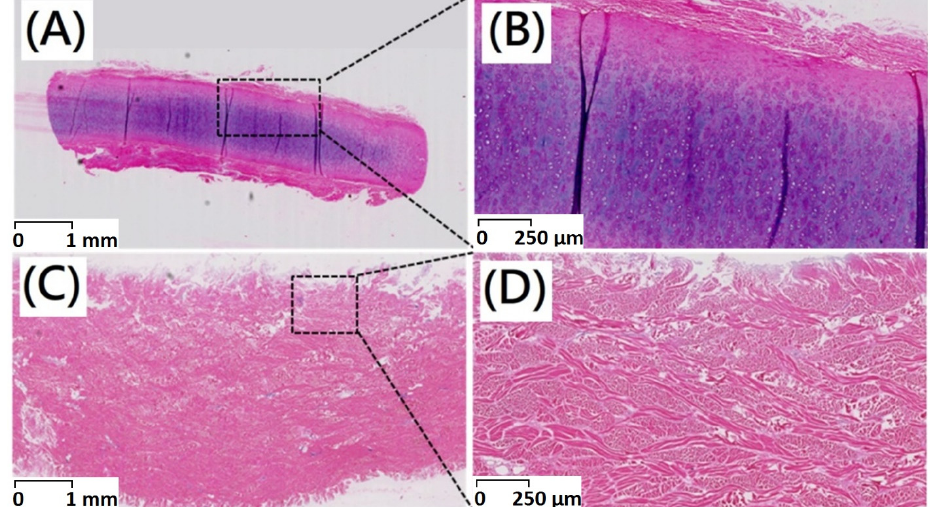
Figure 2. Haematoxylin–eosin staining of ( A ) original porcine dermal (scale bar indicates 1 mm) ( B ) original porcine dermal (scale bar indicates 250 μ m) ( C ) porcine dermal segments after decellularization (scale bar indicates 1 mm) ( D ) porcine dermal segments after decellularization (scale bar indicates 250 μ m).